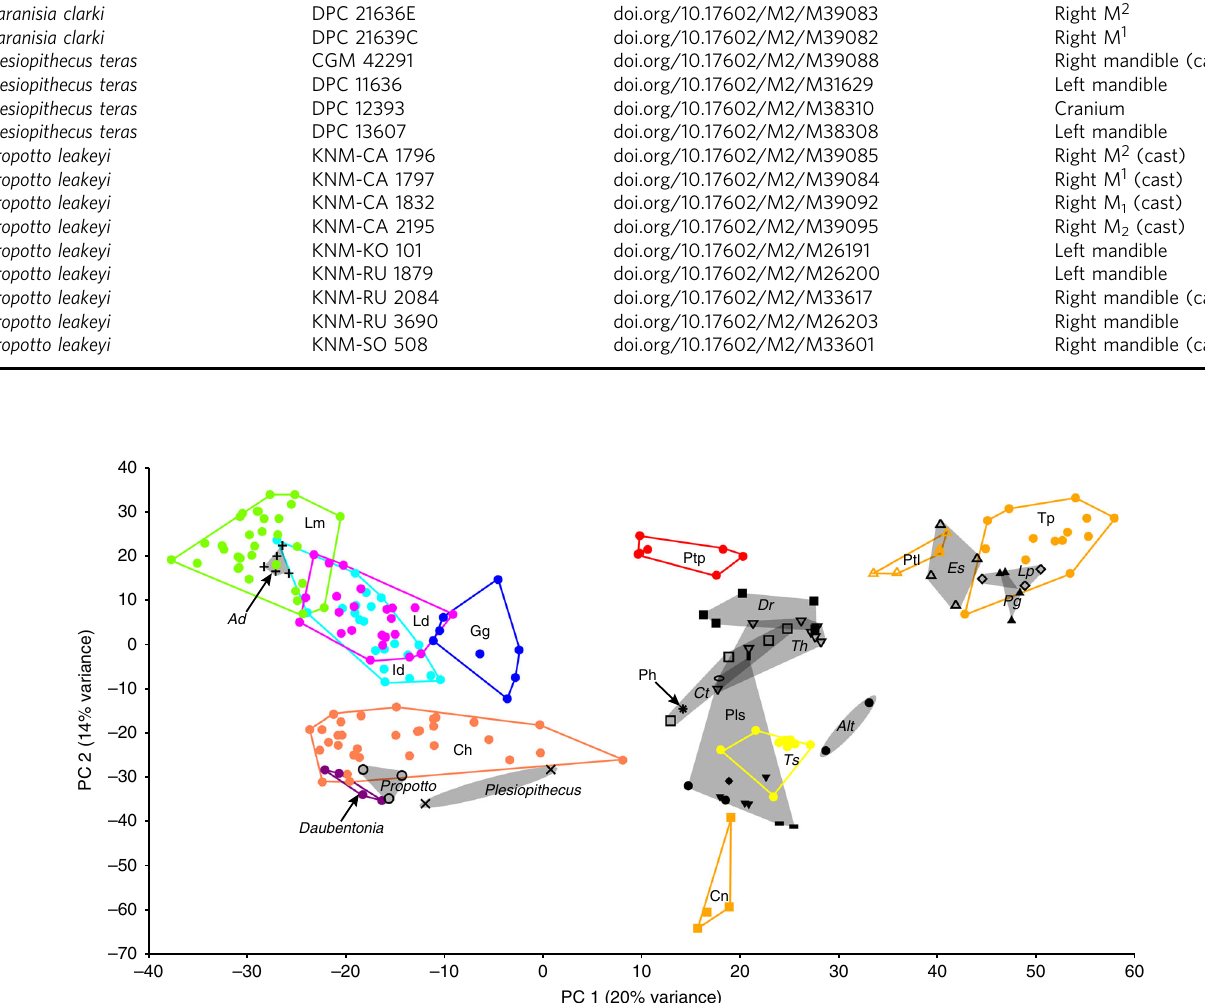
Table 1 DOI addresses for digital surface models of fi gured fossil specimens